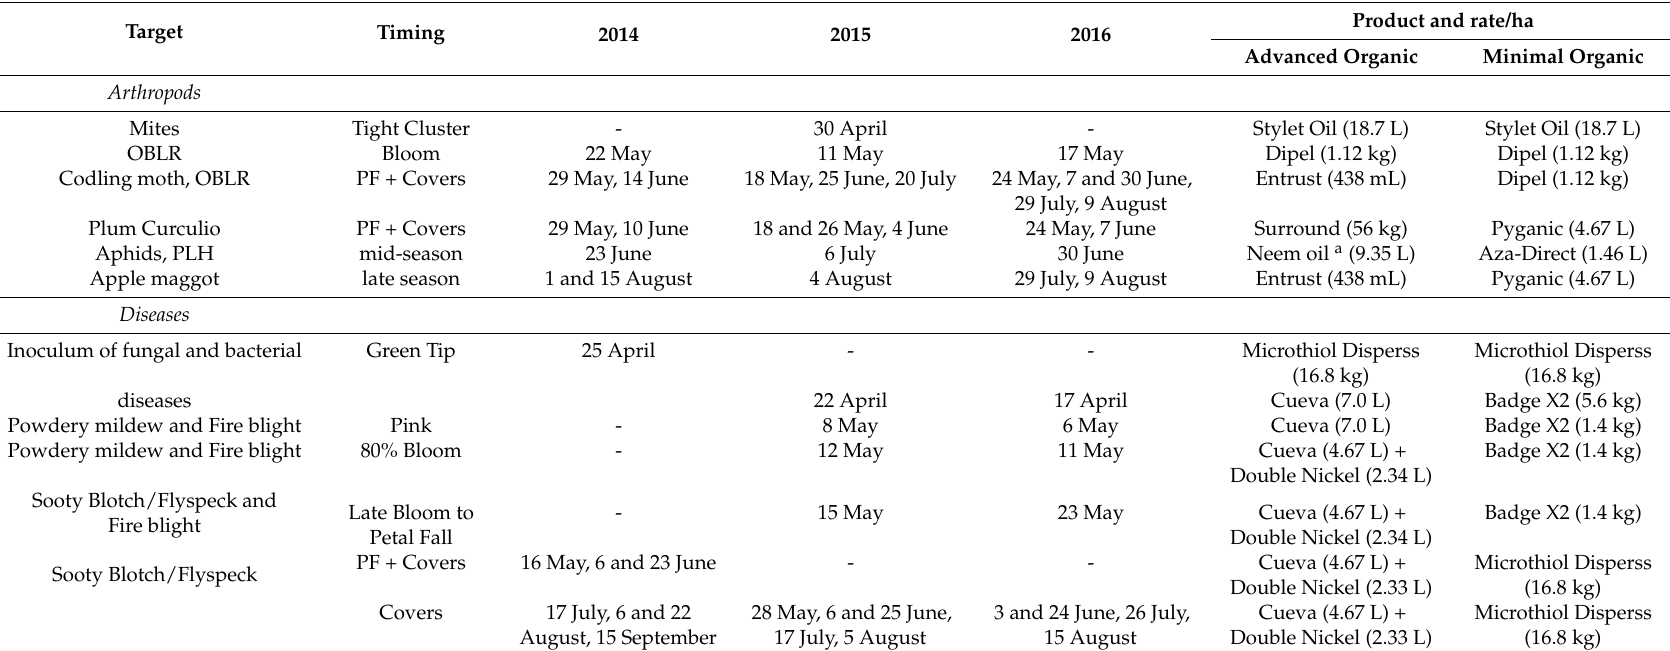
Table 1. Organic Apple Spray Programs,